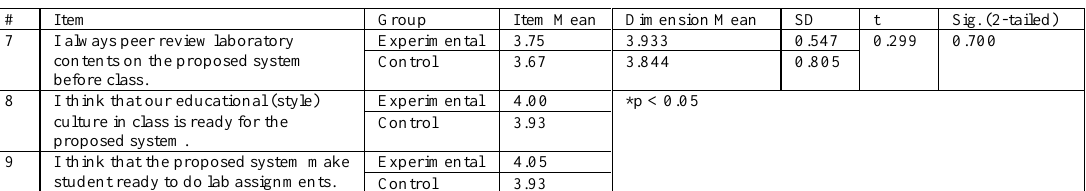
Table 3 Perceived Readiness from using NVBLab.